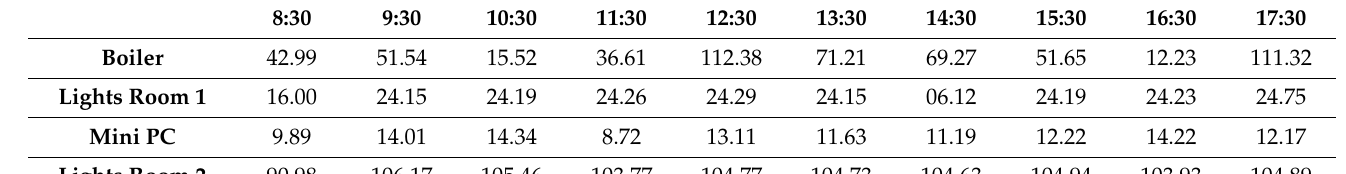
Table 6. Working day energy metering in a typical apartment (Wh).